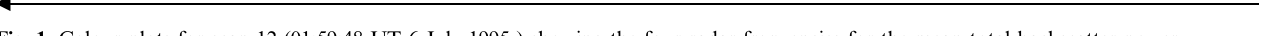
Fig. 1. Colour plots for scan 12 (01:59:48 UT 6 July 1995 ) showing the four radar frequencies for the mean total backscatter power Fig. 2. Colour plots for a fixed range of 192 km (01:17:12 to 04:19:14 UT 6 July 1995) showing the four radar frequencies for mean spectral